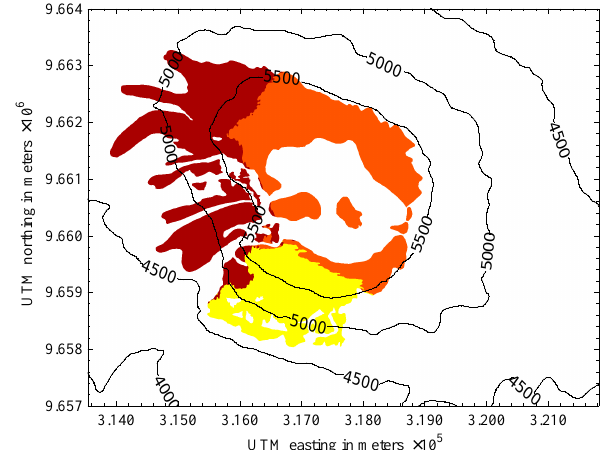
Fig. 4. Classification of regions based on the distribution of topo- graphic measures in 1912. Zone 1 (western region), zone 2 (plateau region) and zone 3 (southern region) are shown in red, orange and yellow,